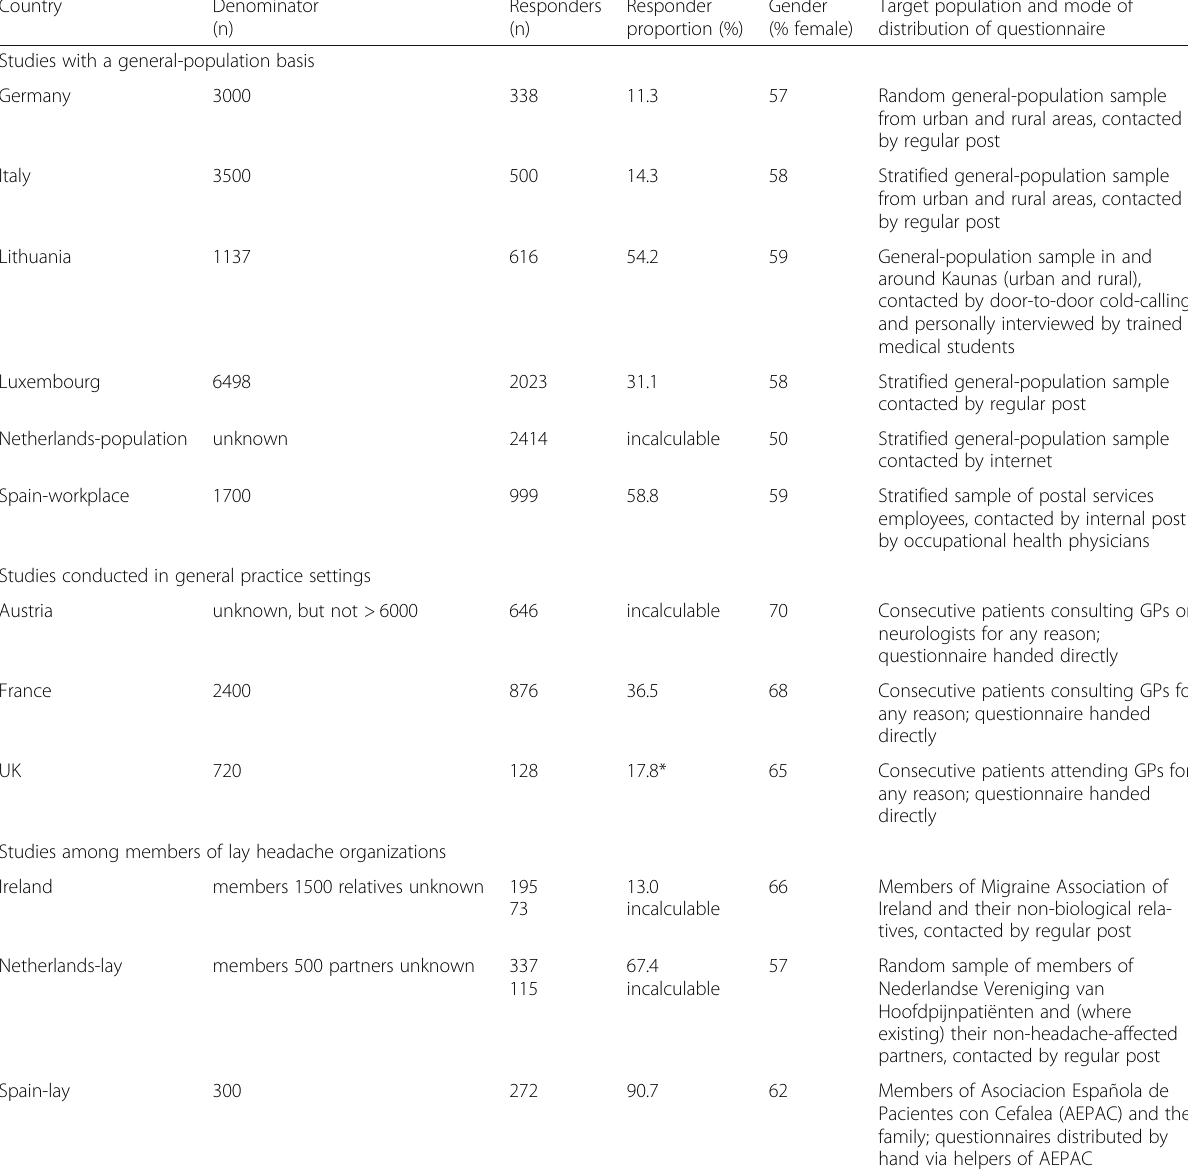
Table 1 Summary of sampling and data collection methods in each country [adapted from reference [12] Country Denominator Responders (n)